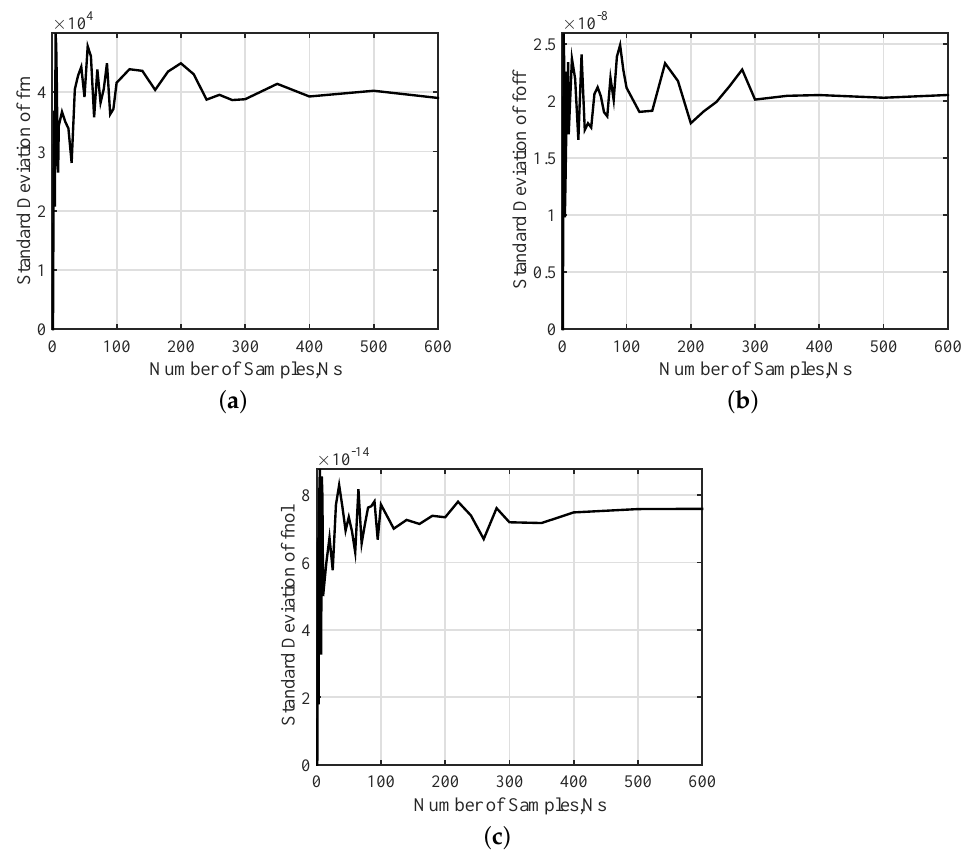
Figure 9. Stochastic convergence analysis of Standard deviation of output parameters: ( a ) f rn , ( b ) f of f and ( c ) f nol